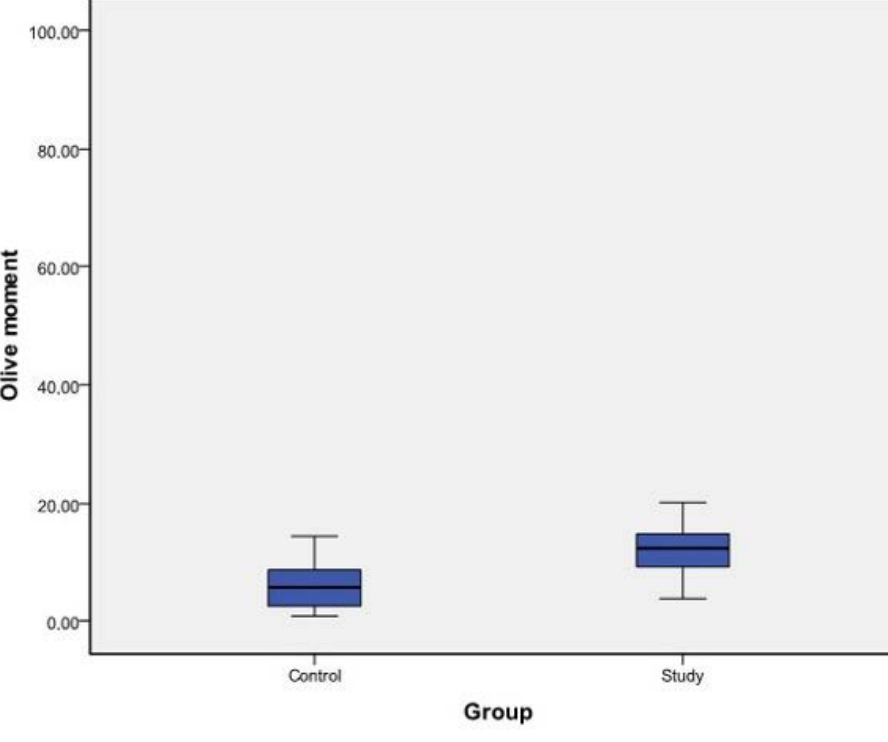
Figure 2. Olive moment ranges and mean differences between the study and control